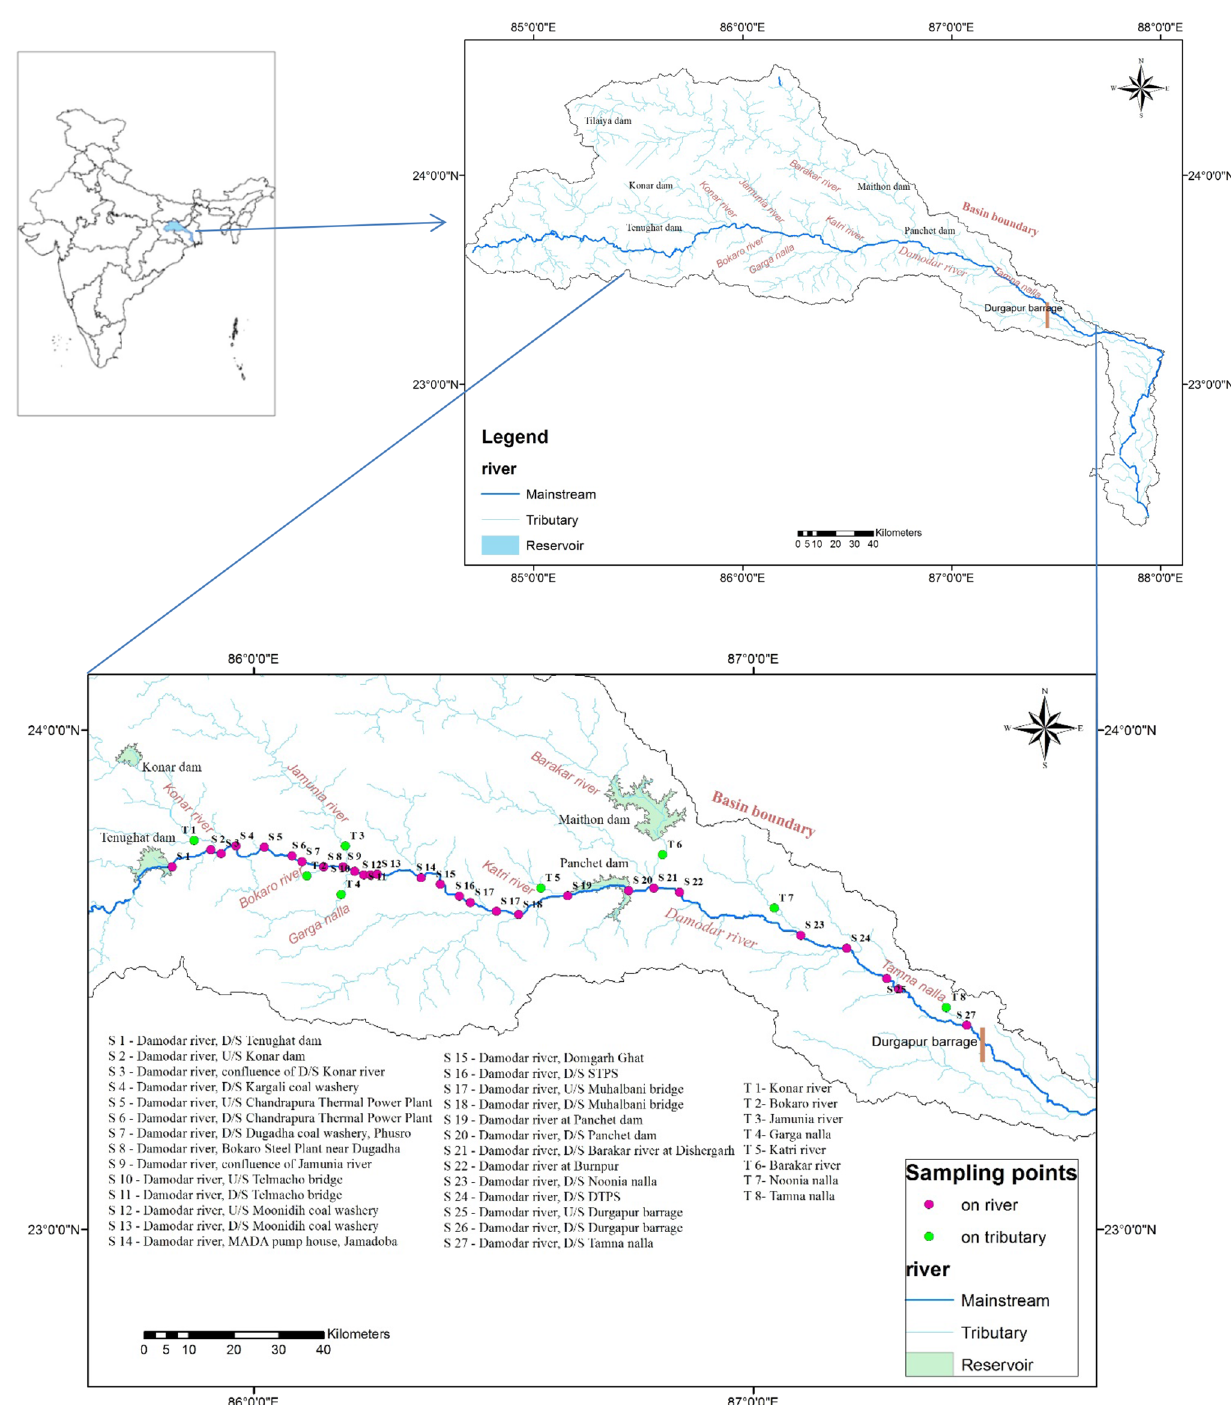
Fig. 1 Map showing location of study area and sampling